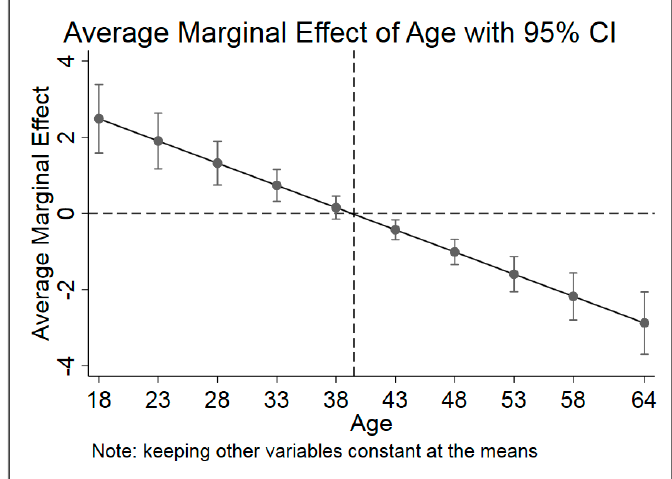
Figure 4. Average marginal effect of age with 95% CI.